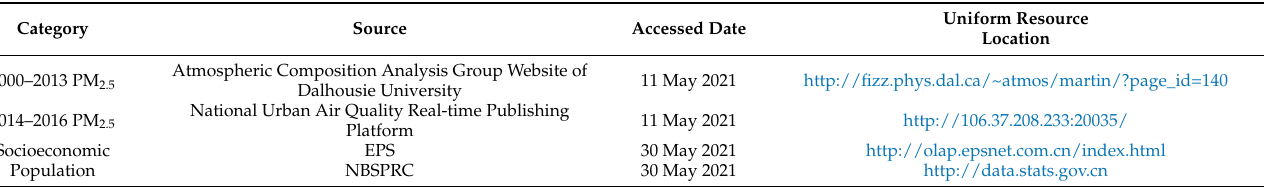
Table 2. The list of datasets with their sources and download